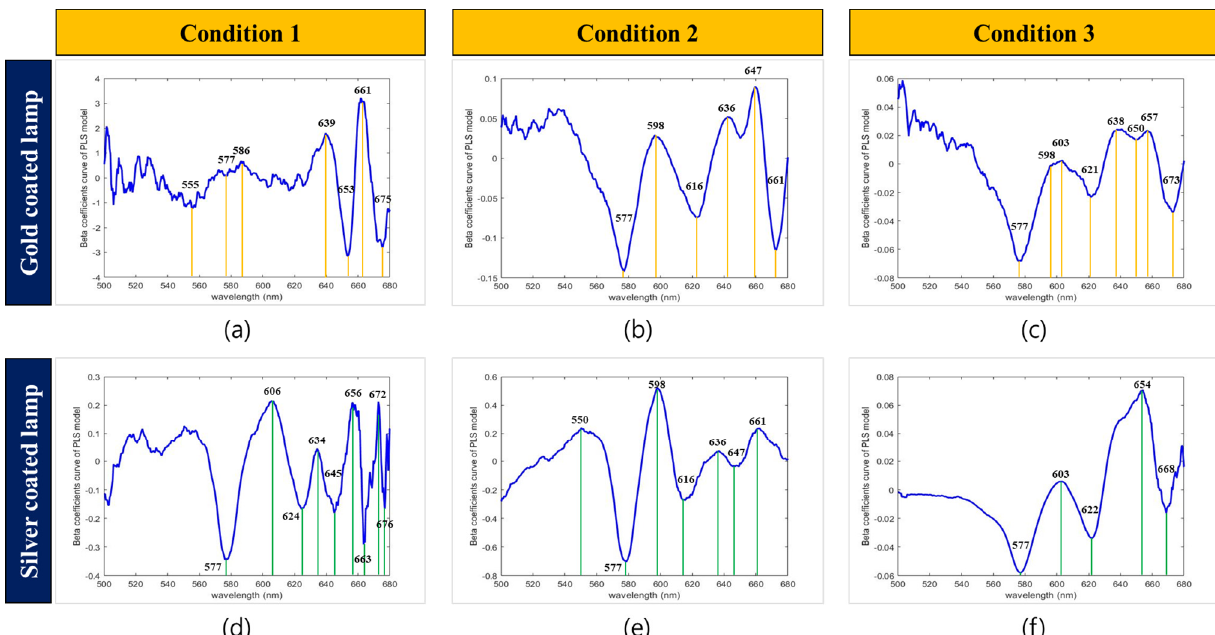
Figure 9. The beta coefficient value of the abnormal egg classification model. ( a ) Gold − coated condition 1 beta coefficient; ( b ) gold − coated condition 2 beta coefficient; ( c ) gold − coated condition 3 beta coefficient; ( d ) silver − coated condition 1 beta coefficient; ( e ) silver − coated condition 2 beta coefficient; ( f ) silver-coated condition 3 beta coefficient.